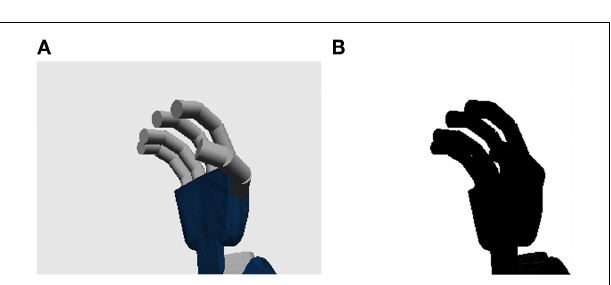
FIGURE 4 | Example of silhouette segmentation . The silhouette is a binary image (B) extracted from an image of the iCub hand (A) computed by image segmentation techniques. Results obtained from the iCub